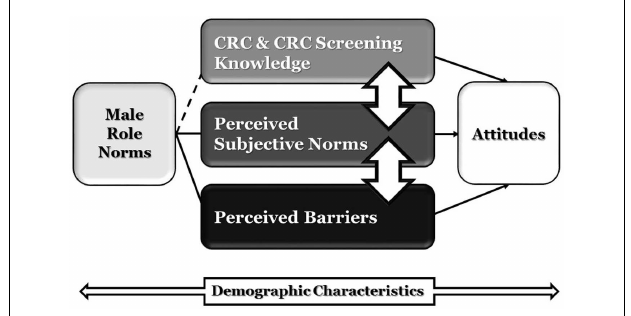
FIGURE 1 | Conceptual model of factors shaping attitudes toward CRC and CRCS among young adultAfricanAmerican men